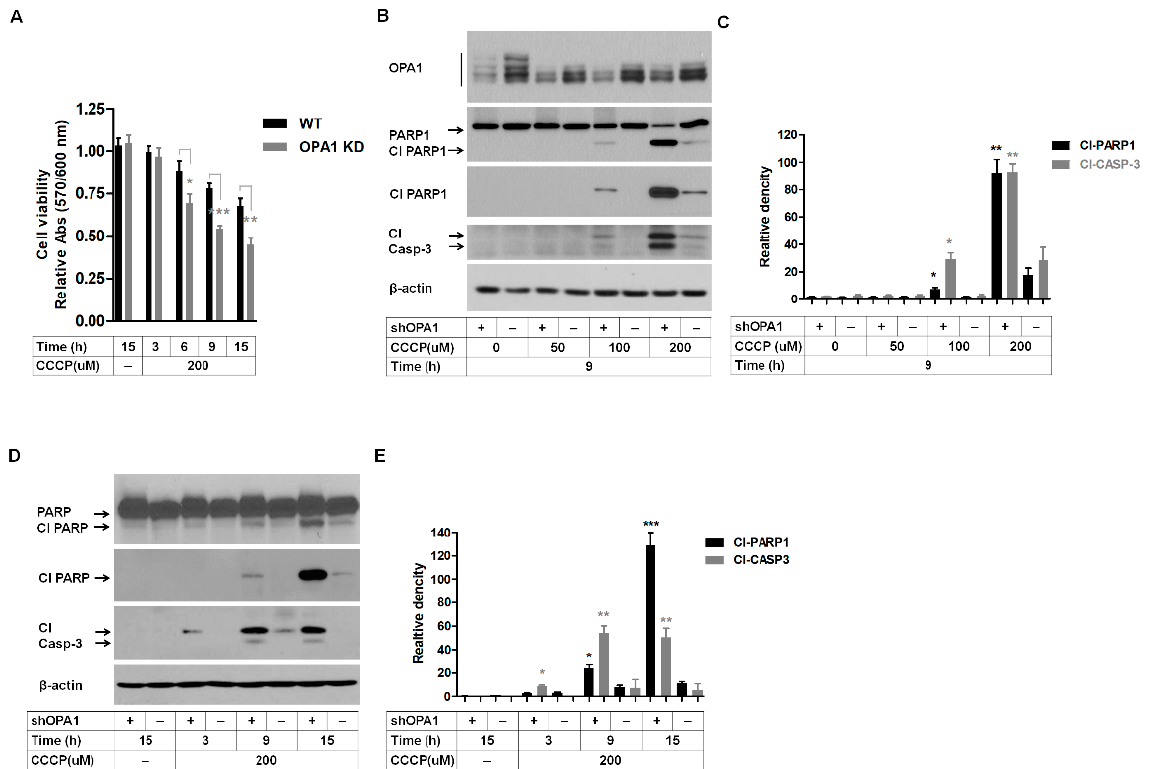
Figure 4. Reduction of OPA1 increases the susceptibility to cell death. ( A ) After treatment with CCCP (200 μ M) for ~3 to 15 h, reversal of CCCP-induced toxicity either by 200 μ M or 0 μ M was investigated using Presto Blue cell viability reagent (Invitrogen). Experiments were performed in triplicate. Data were expressed as mean ± SD. ( B ) Cleavage of PARP1 and casp-3 were analyzed by Western blots following 9 h treatment with indicated concentrations of CCCP in corneal and OPA1-KD corneal fibroblasts. β -actin was used as a loading control. shOPA1; knockdown OPA1 cells with lenti-shRNA-OPA1, +; OPA1-KD cells, − ; control cells, Cl; cleaved. ( C ) The quantification of cleavage bands of PARP1 and casp-3 in the previous panel ( B ). The bars represent the relative increase in treated versus untreated control and OPA1-KD corneal fibroblasts from 3 independent experiments ± SD. ( D ) Cells treated with 200 µ M CCCP for 3, 9, and 15 h, and PARP1 and casp-3 cleavage was assessed in whole-cell extracts from cells treated as described above using Western blotting. β -actin was used as the loading control. ( E ) The quantification of cleavage bands of PARP1 and casp-3 in the previous panel ( D ). The bars shown are representative of the results of 3 independent experiments. * p < 0.05, ** p < 0.01, and *** p < 0.001 as compared to control, Student’s t -test.